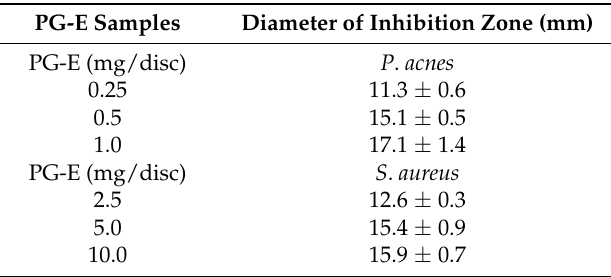
Table 2. Anti- P . acnes and S . aureus effects of pomegranate extract (PG-E).